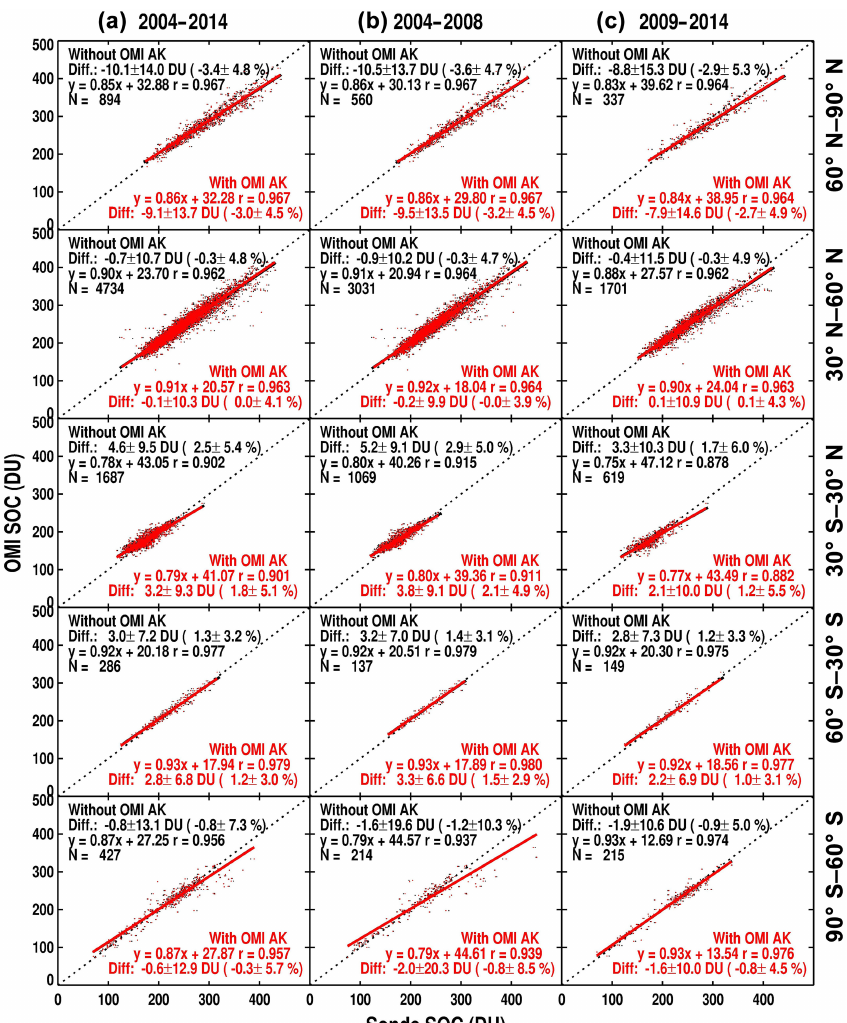
Figure 8. Scatter plots of OMI stratospheric ozone columns (SOCs) vs. ozonesonde SOCs without (black) and with (red) averaging kernels for five different latitude bands during 2004–2014 (a) , the pre-row anomaly (RA) period (i.e., 2004–2008, b ) and the post-RA period (i.e., 2009–2014, c ), respectively. Comparison statistics including mean biases and standard deviations in both DU and %, the linear regression and correlation coefficients in DU, and the number of coincidences are shown in the